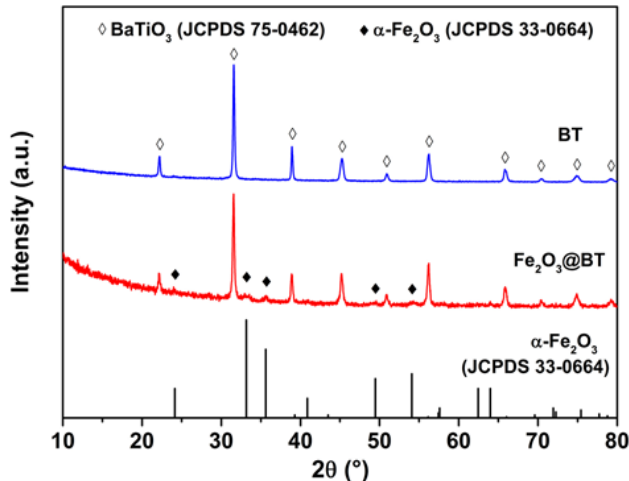
Figure 2. X-ray di ff raction (XRD) patterns of Fe 2 O 3 @BT and BT nanoparticles. Figure 2. X-ray diffraction (XRD) patterns of Fe 2 O 3 @BT and BT nanoparticles.